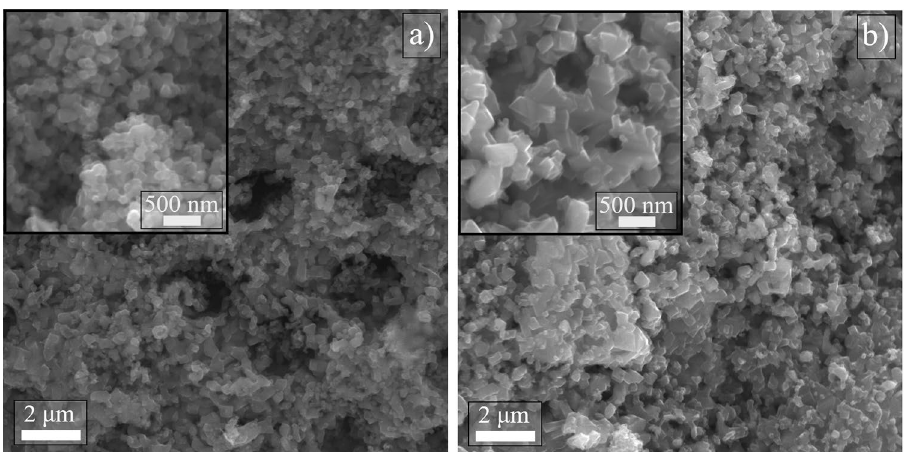
Figure 7. SEM micrographs of the sample ( a ) 30MZ 2 and ( b ) 50MZ 2 after last stage of thermal treatment at 1400 °C. The insets represent corresponding higher magnification images, highlighting particles shape and